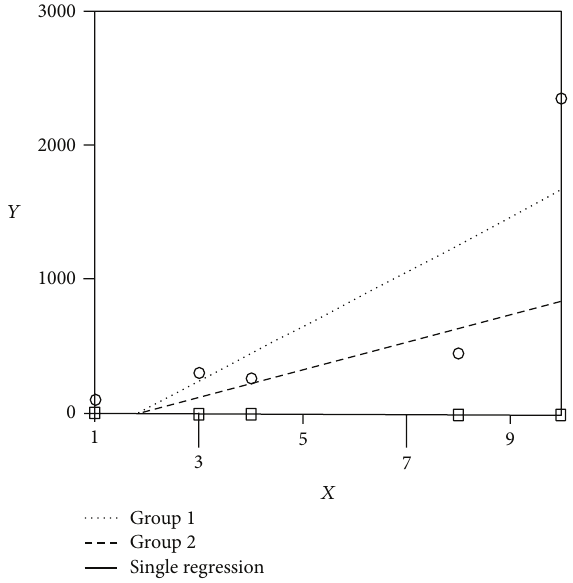
Figure1:Acomparisonofthelinearregressionlinesoftheincreases in serum triglyceride levels over duration of propofol infusion ( ... ) versus increases in serum creatinine levels over duration of propofol infusion ( −−− ). Note: the creatinine levels ( −−− ) track the 𝑥 -axis at 0-1 and are reflected in the single regression line. Although there is no difference in the line slopes ( 𝑃 = 0.56 ) or in the 𝑦 -intercepts ( 𝑃 = 0.515 ) of the regression lines, there is a statistically significant difference in the 𝐹 -test of coincidence between the lines indicating significantly greater correlation of increasing triglyceride levels with duration of propofol infusion ( 𝐹 = 5.773 , 𝑃 = 0.04